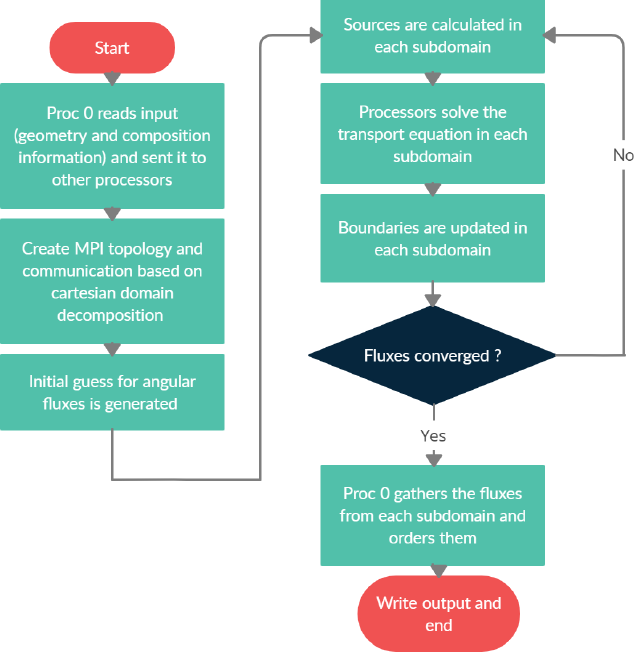
Figure 3. Flowchart of parallel AZTRAN